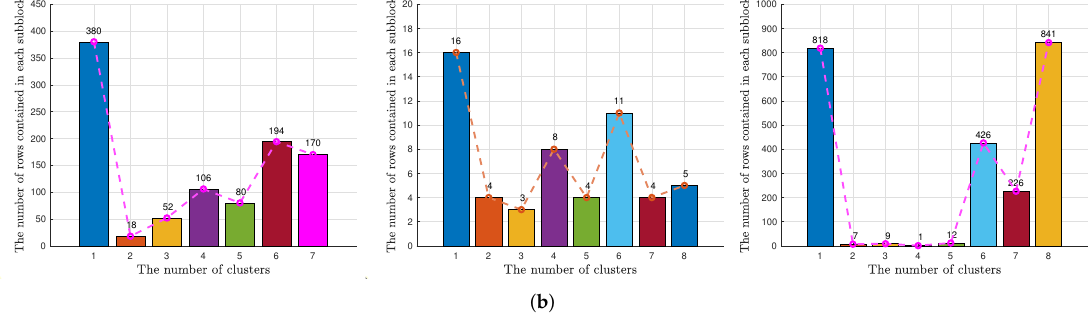
Figure 1. Clustering performance of the MS( δ ) Algorithm 3 on matrices A ∈ R 1000 × 500 with δ = 0.45 (left), “Cities” with δ = 0.45 (middle), and “relat6” with δ = 0.3 (right). ( a ) The cluster visualizations of system matrix A ∈ R 1000 × 500 (left), “Cities” (middle), and “relat6” (right). ( b ) The number of rows contained in each subblock of the matrix A ∈ R 1000 × 500 (left), “Cities” (middle), and “relat6”